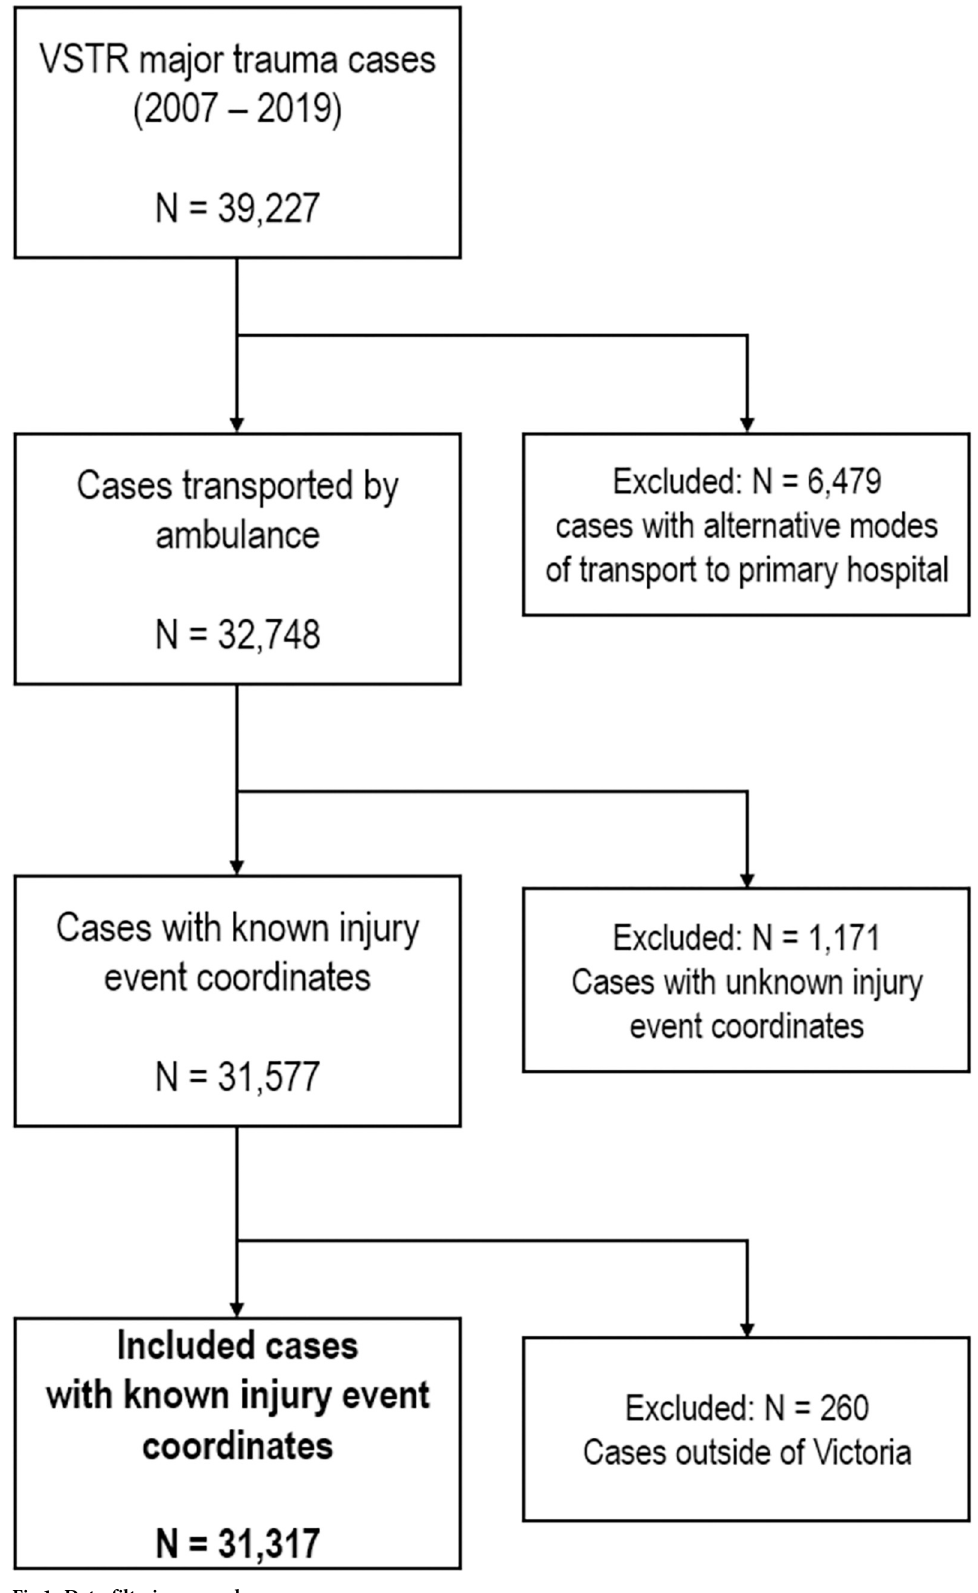
Fig 1. Data-filtering